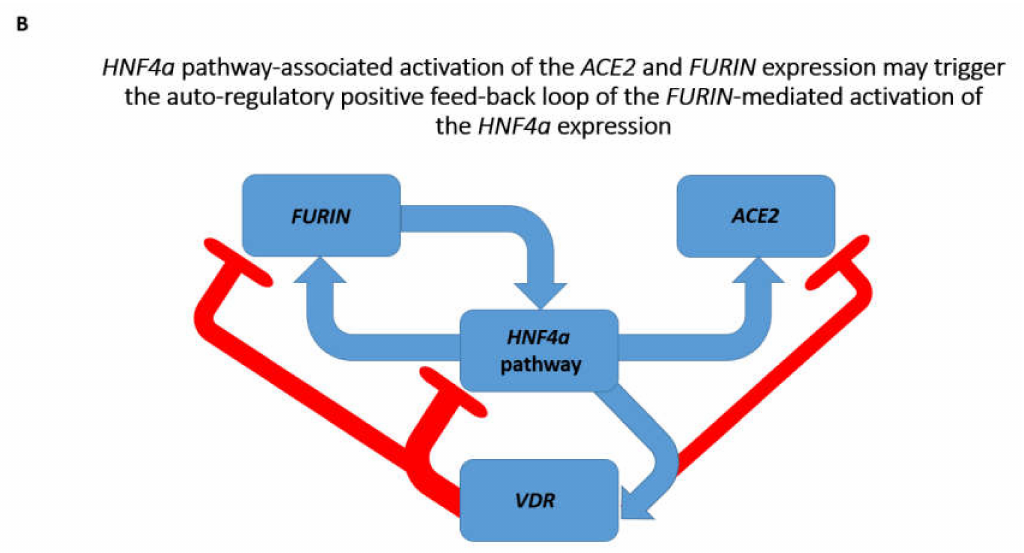
Figure 3. E ff ects of the VDR gene and vitamin D on pathways and genes a ff ecting the newly emerged SARS-CoV-2 virus-related host targets. ( A ). JNK1 / c-FOS pathway-associated activation of the ACE2 and FURIN expression may trigger the auto-regulatory negative feed-back loop of the FURIN -mediated repression of the expression of JUN, JUNB, JUND , and c-FOS genes. ( B ). HNF4a pathway-associated activation of the ACE2 and FURIN expression may trigger the auto-regulatory positive feed-back loop of the FURIN -mediated activation of the HNF4a expression. Activation of VDR gene would block JNK1 / c-FOS - and HNF4a -mediated increased expression of both ACE2 and FURIN